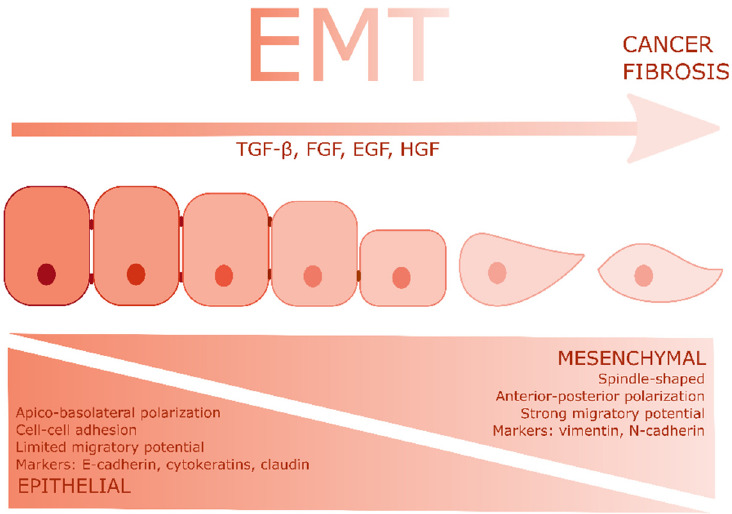
Figure 1. Epithelial to mesenchymal transition: TGF β and growth factors induce EMT in epithelial cells, which is accompanied by the loss of typical epithelial features and the acquisition of mesenchymal characteristics.